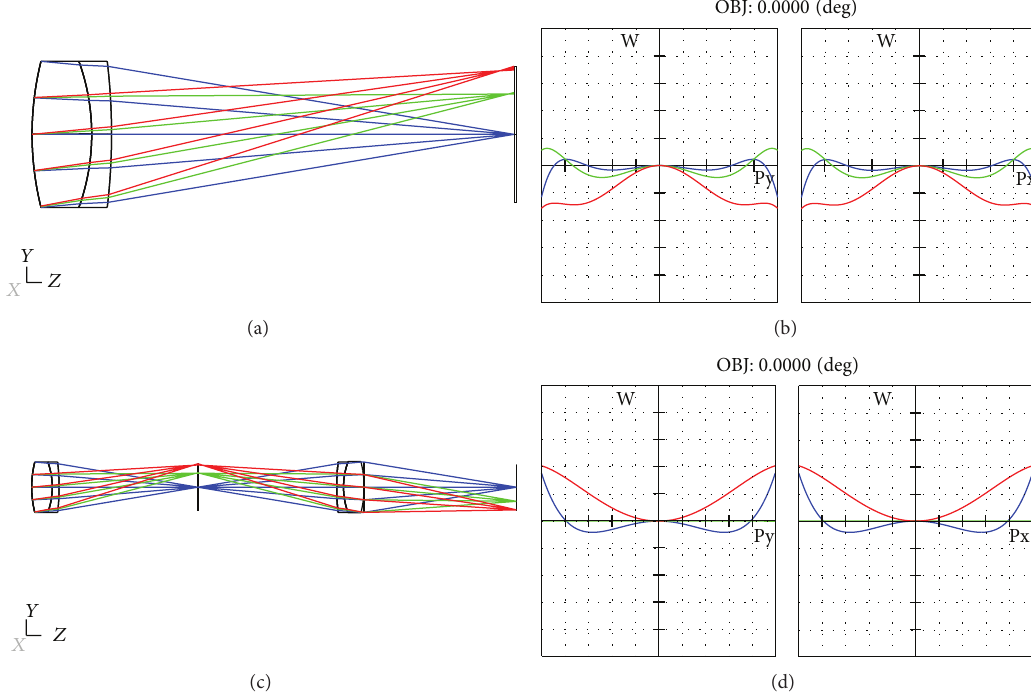
Figure 2: Edmund Optics 20 mm achromatic doublet: (a) original lens and (b) on axis OPD fan, (c) forward and reversed ray tracing model and (d) on axis OPD fan. The OPD fan full scale is 0.5 waves.